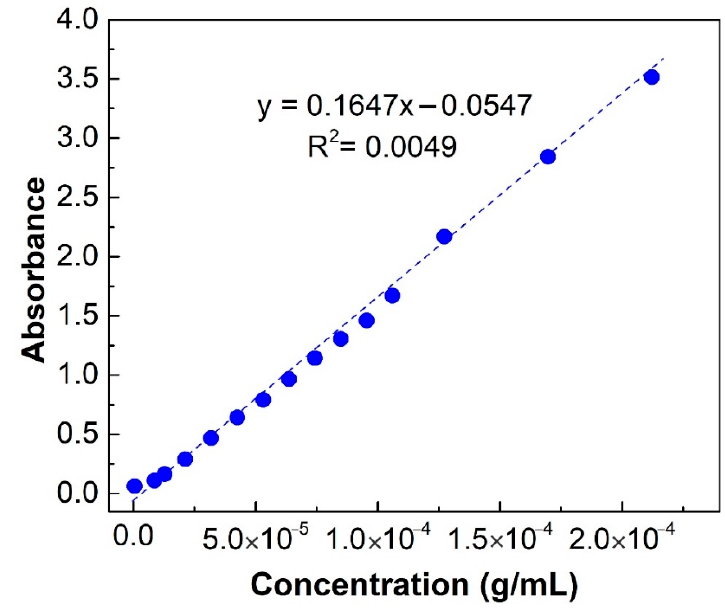
Figure 4. Absorbance plotted as function of concentration for AM in ethanol. The kinetics of the polymerization reaction is one of the great indicators of whether the RAFT polymerization process matches CRP. The link between number average molecular weight and monomer conversion is seen in Figure 5. The conversion of monomer to polymer grows linearly with reaction time, and the number average molecular weight of the polymer also increases linearly with conversion. Due to the high reaction temperature, the primary radicals were produced virtually instantly, and the radicals increased gradually in the presence of chain transfer agents, while the reversible-break transfer process successfully regulated the incidence of double-group termination. Consequently, the above kinetic results show that RAFT polymerization of AM may be accomplished utilizing DMPA as the chain